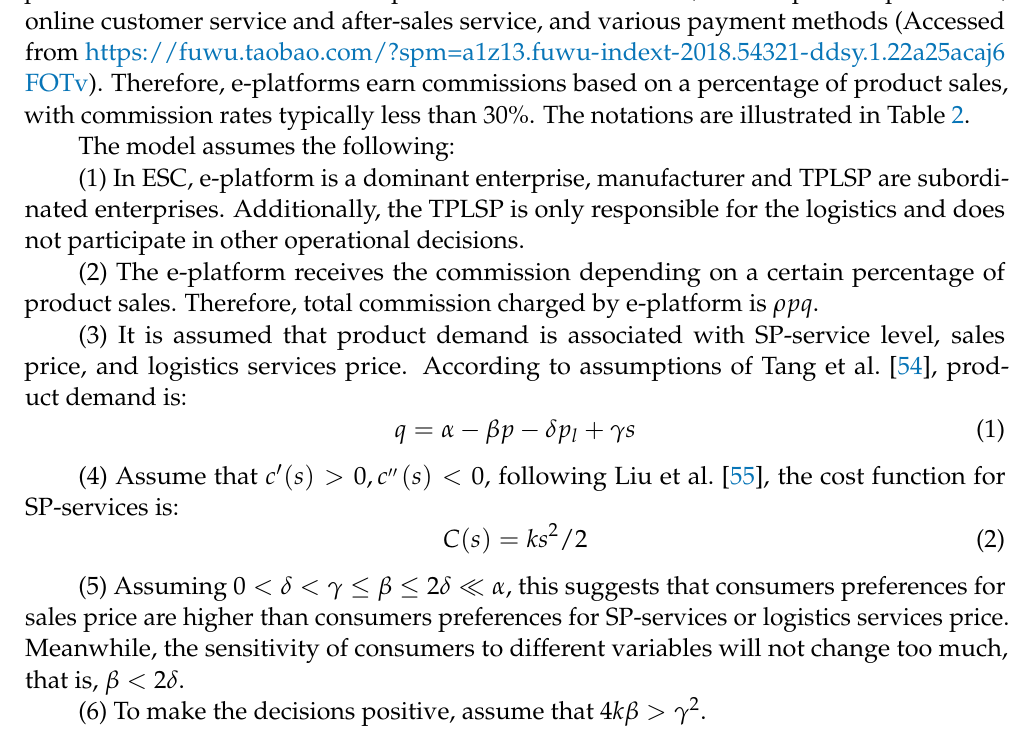
Table 2. Notations description.